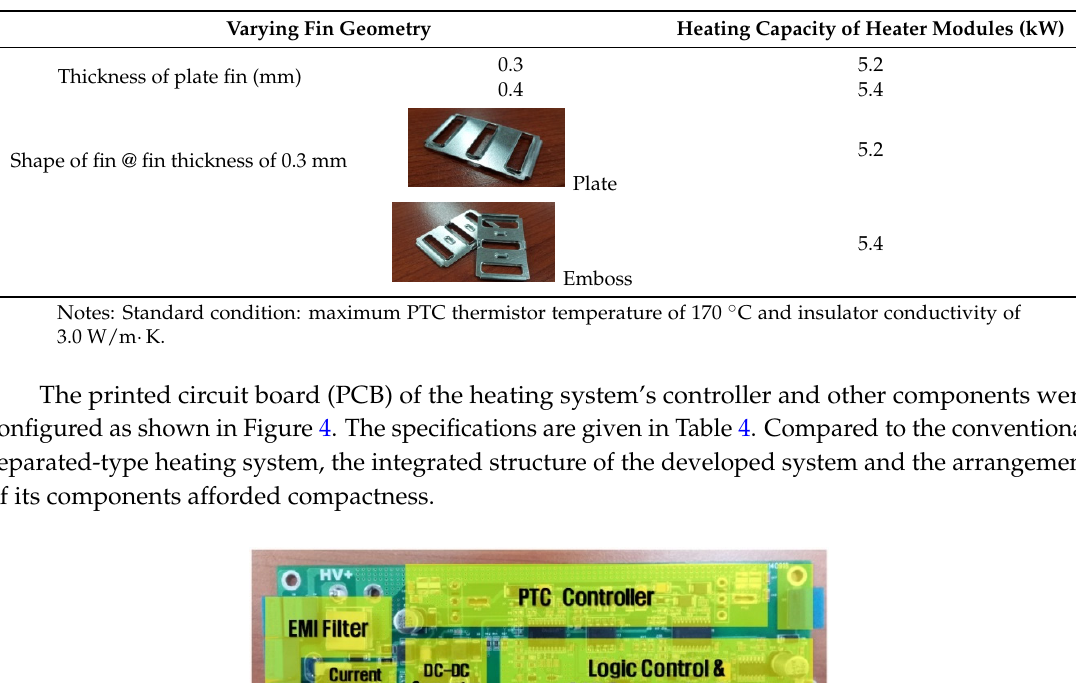
Table 3. Experimental results of the heater module performance for varying fin geometry.